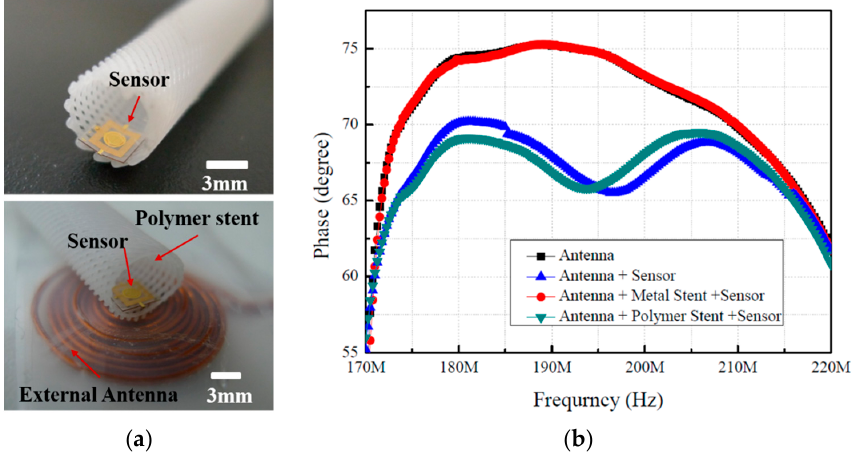
Figure 7. ( a ) Optical images of polymer stents integrated with wireless pressure sensors; ( b ) electrical influence of a metallic stent in the radio frequency (RF) experiments.